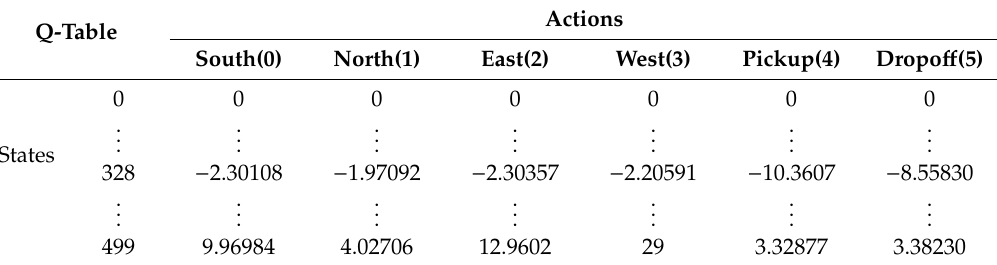
Table 1. Schematic diagram of a